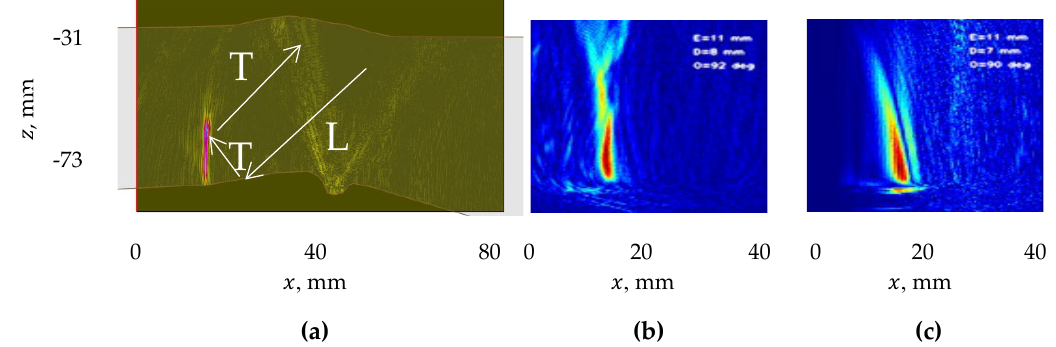
Figure 16. CEA data set. The backwall notch imaged with a 64 element transducer array, using the half-skip LTT mode as processed by ( a ) CIVA and AutoNDE, ( b ) employing the standard TFM algo-rithm and ( c ) MTFM (intensity threshold = 185 and Dm = −